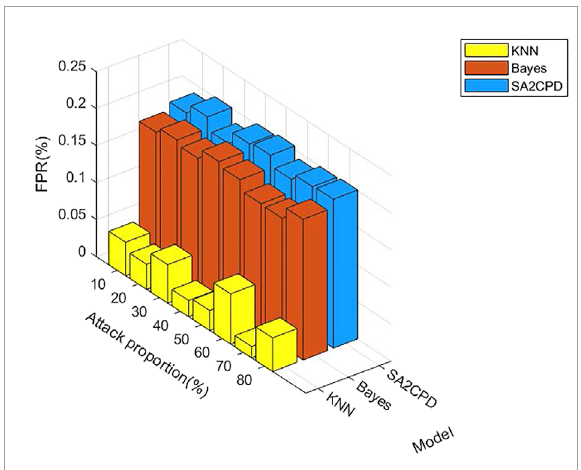
FIGURE 8 The FPR of our SA2CPD model, the Naive Bayes model and the KNN model under different attack proportions.